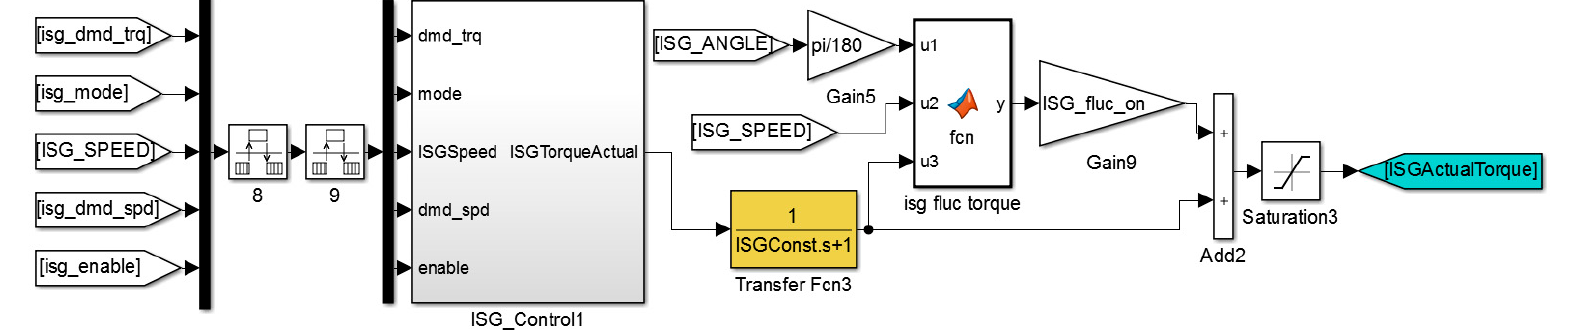
Figure A4. ISG controler in